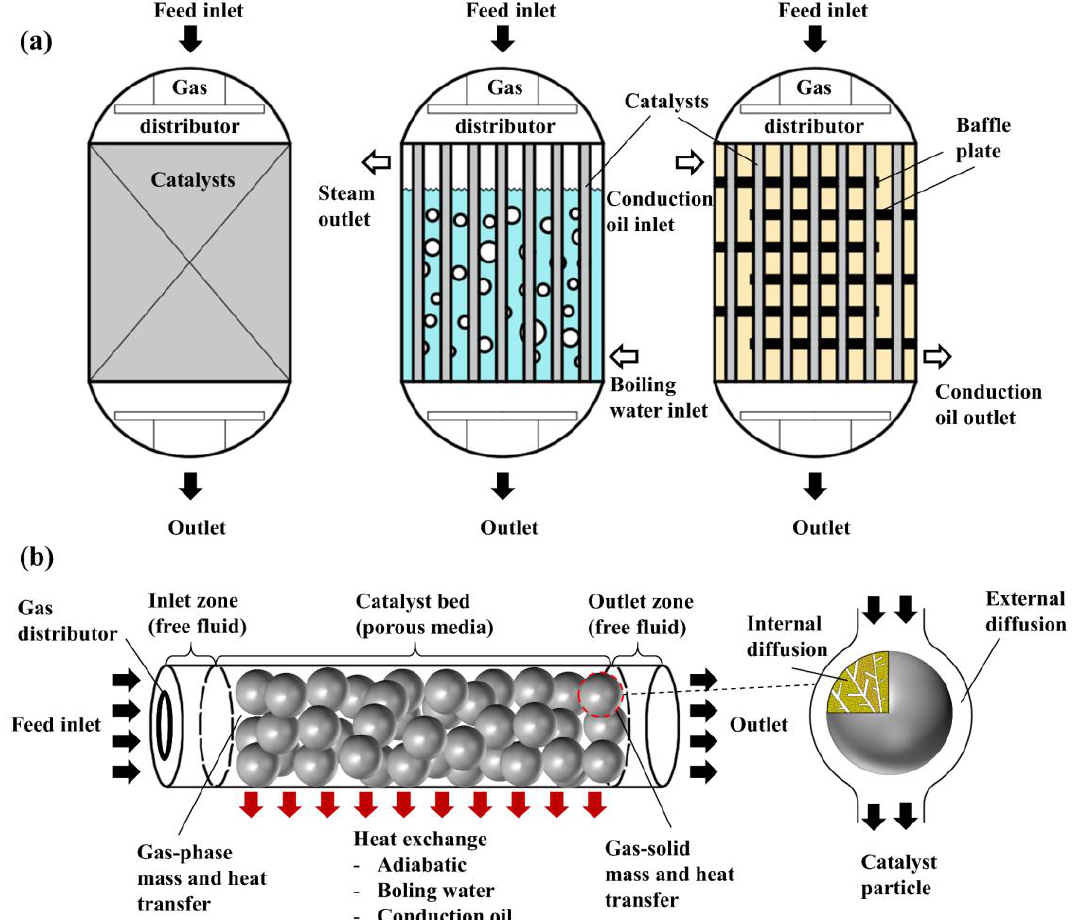
Figure 2. Schematic diagram of ( a ) industrial adiabatic and heat-exchange reactors for ethylene carbonate hydrogenation and ( b ) the multi-scale reactor model.